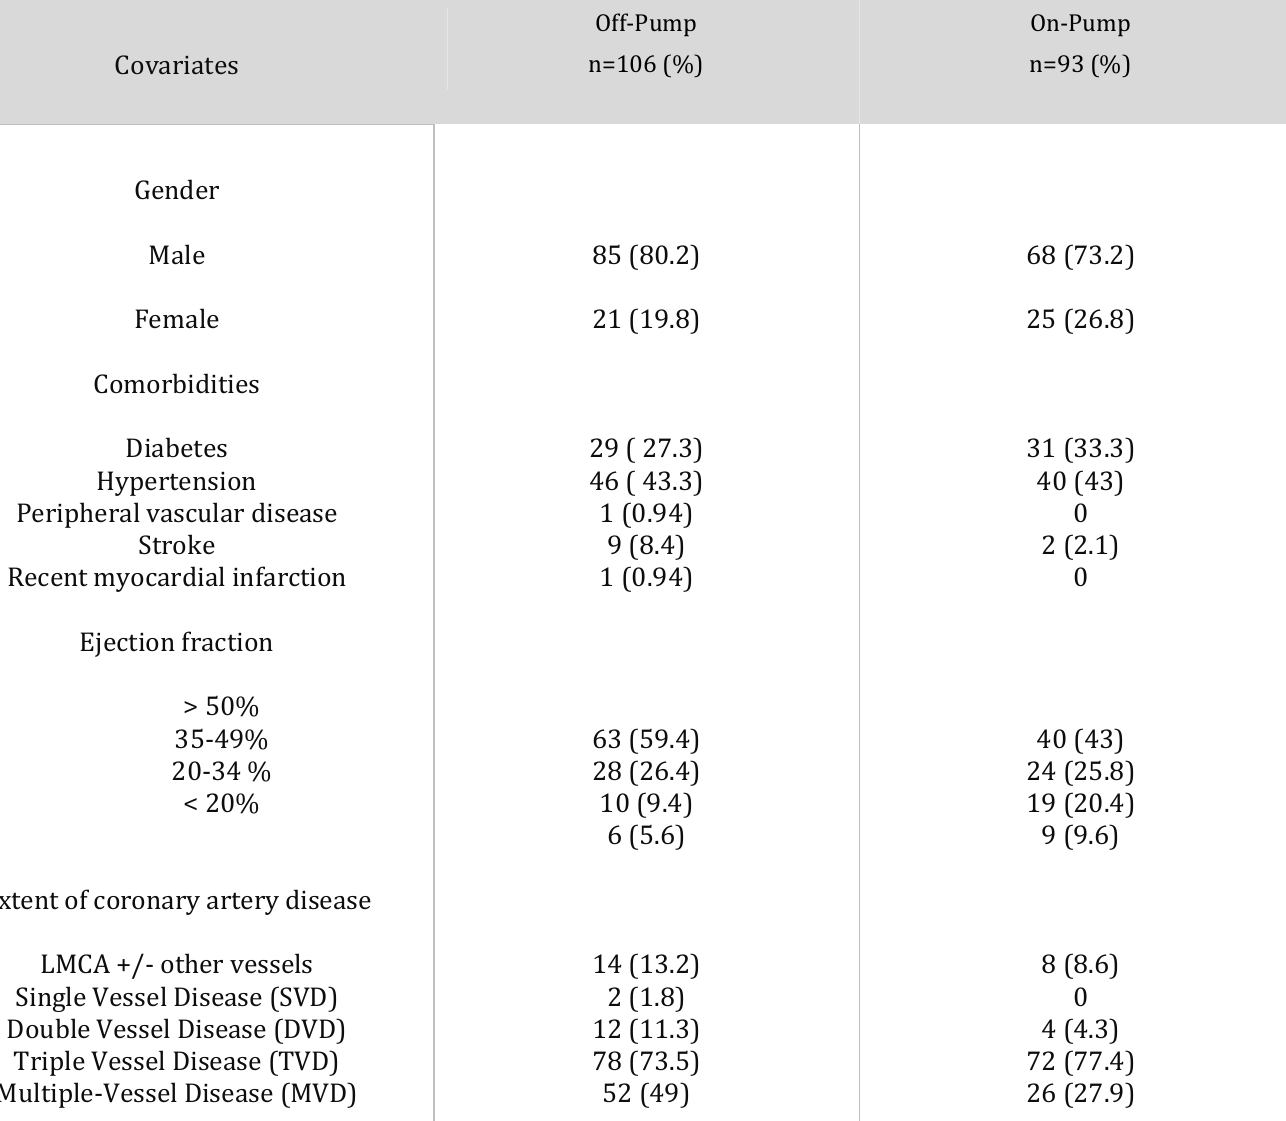
Table 1 . Preoperative characteristics according to surgical strategy Covariates